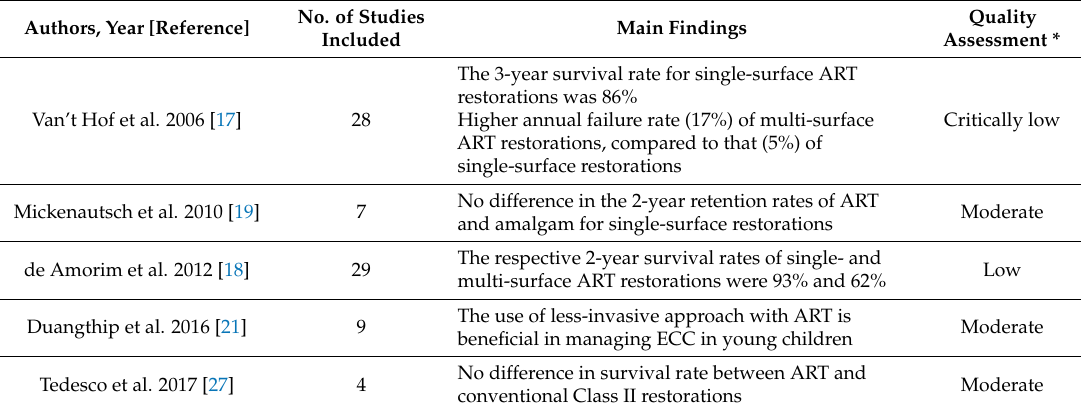
Table 1. Systematic reviews on the effectiveness of atraumatic restorative treatment on primary